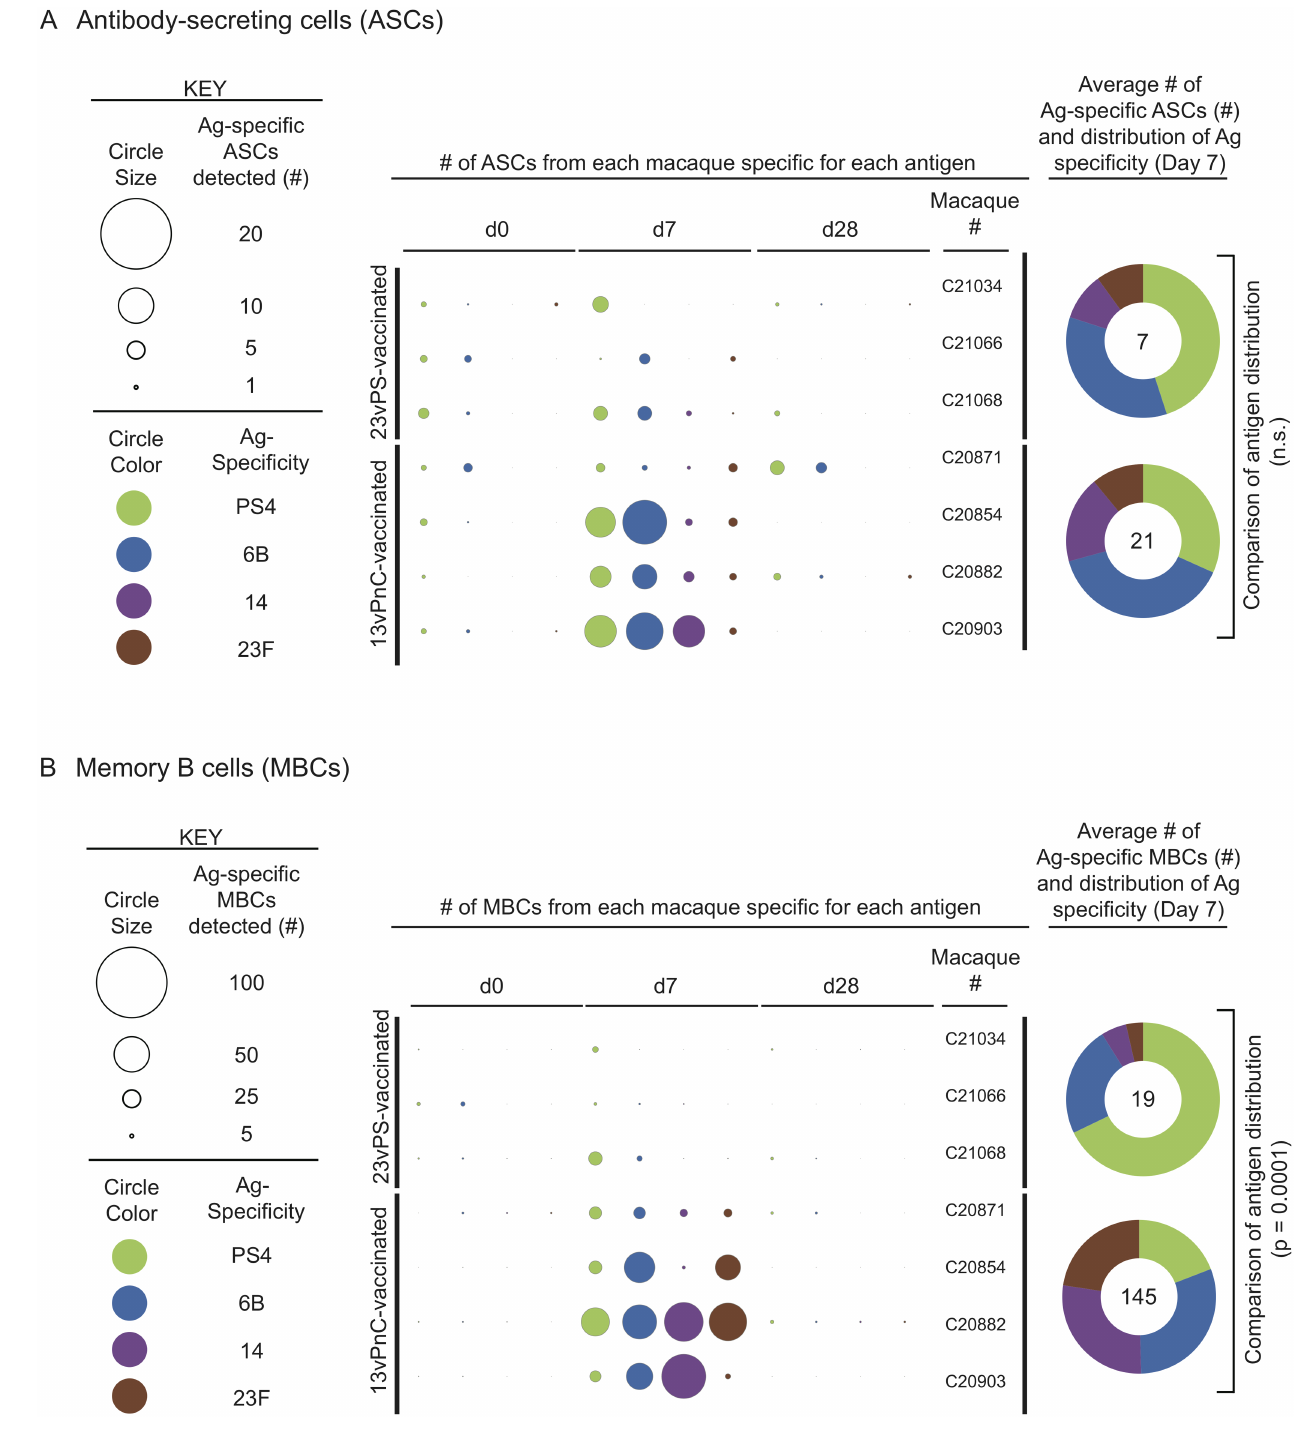
Fig 2. The distribution of polysaccharide-specific antibody-secreting and memory B cells against the four polysaccharides. The number of PS-specificASCs (A) and MBCs (B) specific for each antigenat days 0, 7 and 28 post-vaccination are depicted. The radius of each circle in the center panel is proportional to the number of PS-specific ASCs or MBCs detected, and the antigenspecificity is indicatedby the color of each circle. The antigendistribution for all ASCs and MBCs within each vaccine-group are depicted in pie charts. Numbersin the center of the pie charts indicate the total numbersof ASCs or MBCs detected. The distributionof antigenspecificity was comparedusing a 2XN Fisher’s test.